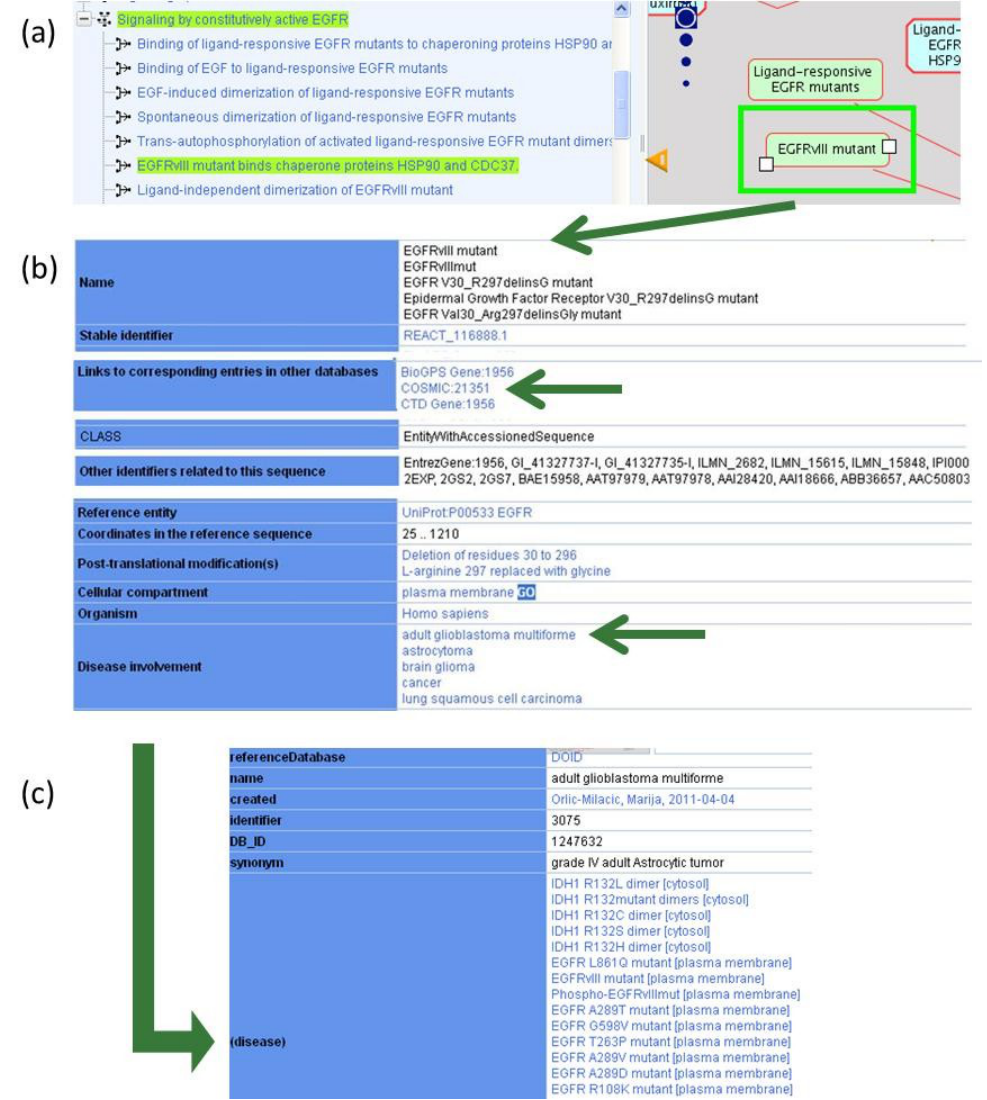
Figure 2. Disease information presented interactively on the Reactome website. ( a ) Selecting an entity in the pathway diagram, EGFRvIII mutant in this case and opening the Reactome details pane by clicking on the yellow triangle at the bottom of the Pathway Browser page brings up a record for the selected instance. A pathway hierarchy displayed on the left hand side shows how the selected instance is related to the rest of the pathway content. ( b ) Reactome record, displayed in the details pane, provides information on the selected entity, including cross-references to other databases such as COSMIC, UniProt, GO. ( c ) Cross-reference to Disease Ontology: clicking on a disease attribute, such as “adult glioblastoma multiforme”, provides a Disease Ontology (DO) identifier for this disease instance (3075) and lists all proteins in Reactome database associated with adult glioblastoma